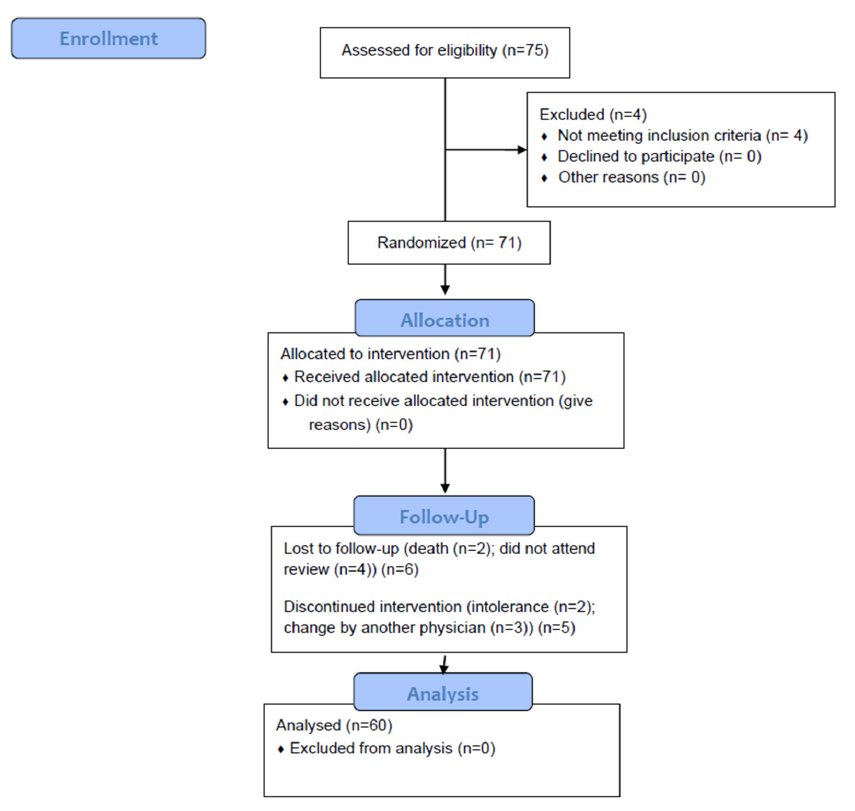
Figure 1. Flow chart. Table 2. Differences in the Morphofunctional Assessment at the beginning according to